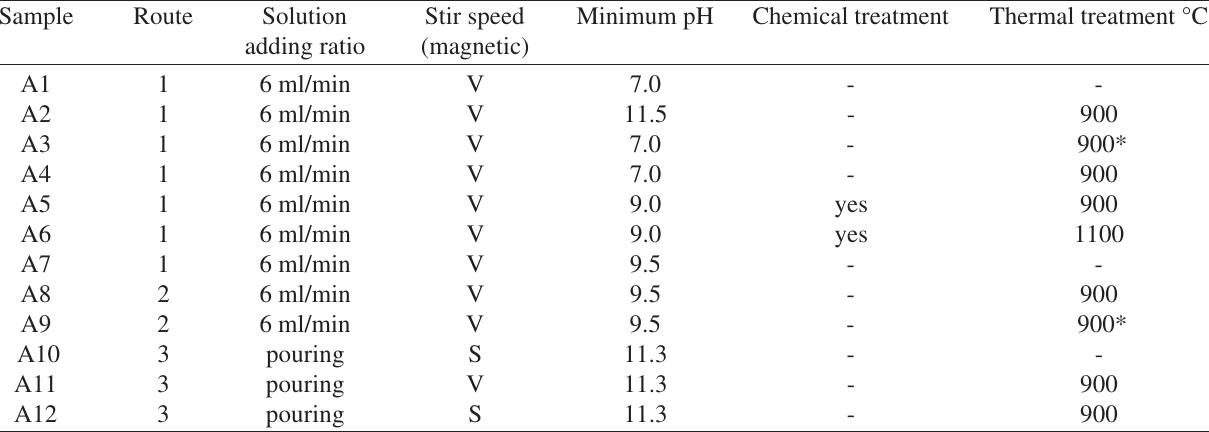
Table 1. HA sample identifications and experimental